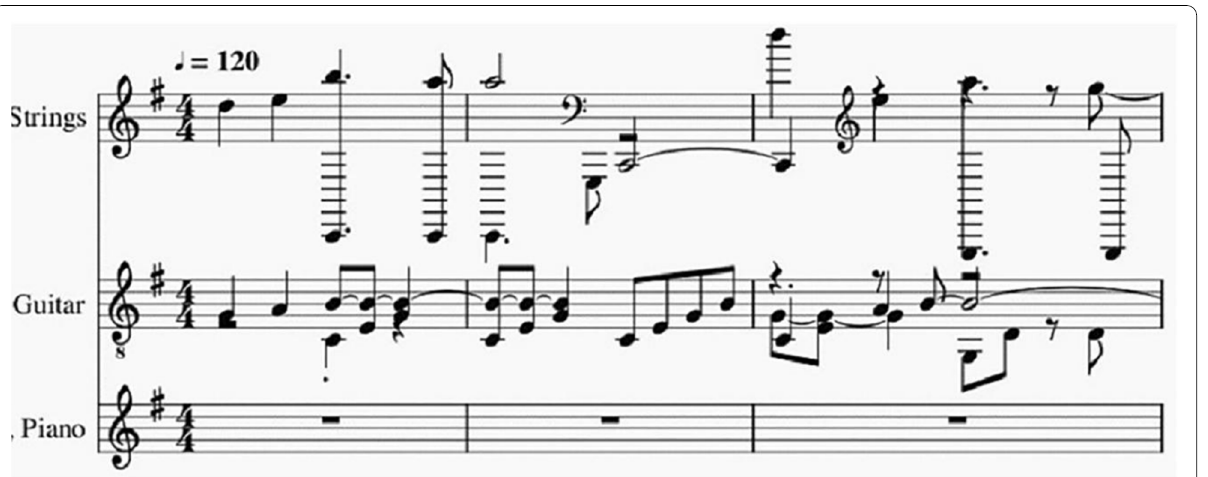
Fig. 5 Part of the music score of the generated